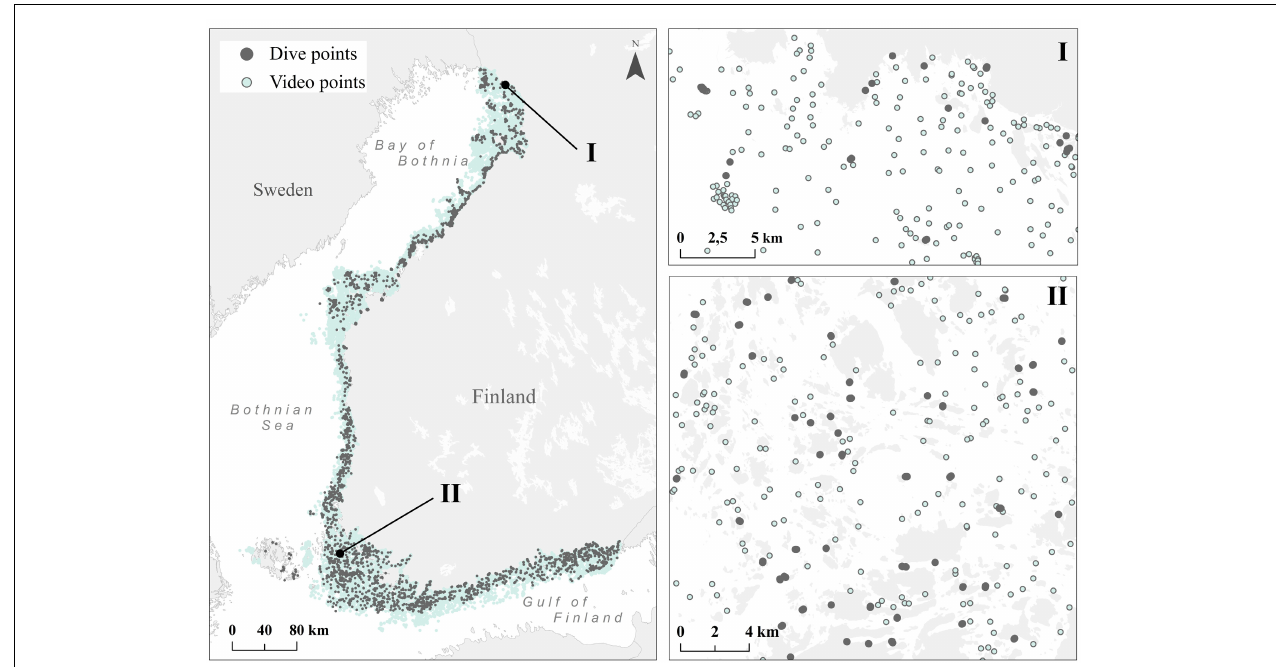
FIGURE 1 | Dive (gray) and video (blue) points collected during the VELMU project 2004–2016 with zoomed-in example areas from the Bothnian Bay (I) and the Archipelago Sea